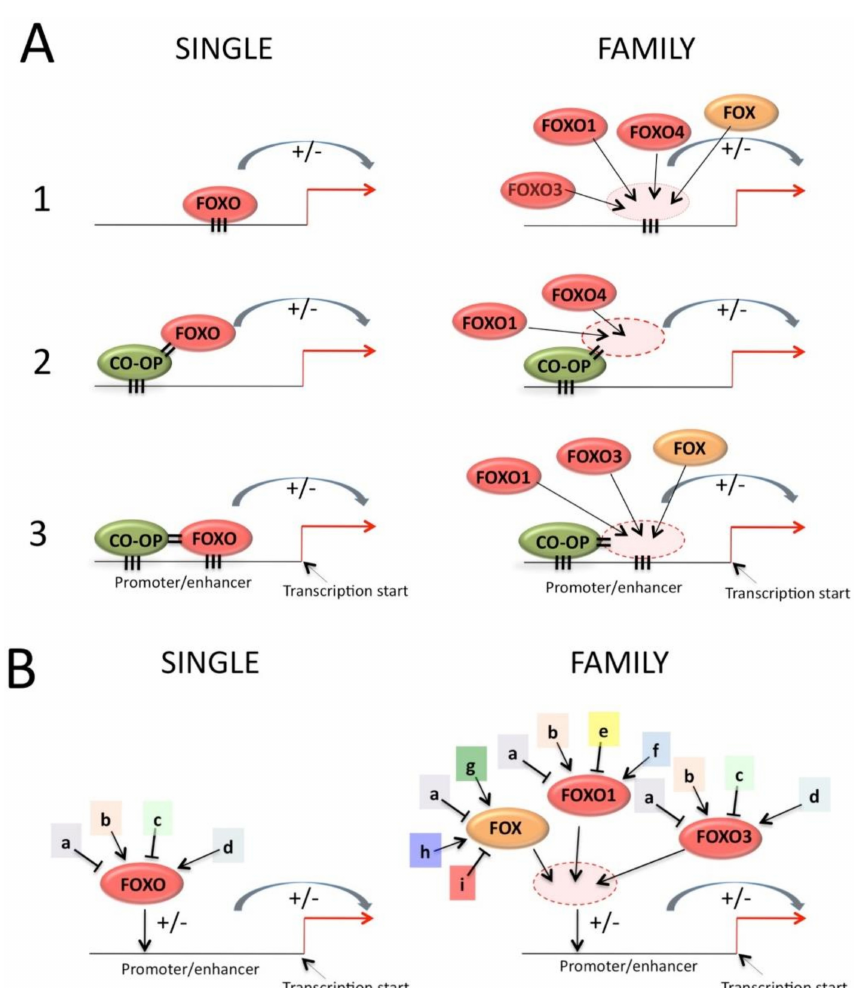
Figure 5. ( A ) Left side: simplified view of the major di ff erent modes of action of FOXOs: 1. Direct DNA-contact, 2. Indirect binding, through another protein making DNA-contact, 3. Pairwise binding, with both proteins making DNA-contact. Right side: Family e ff ect for the di ff erent mode of action. ( B ) Left side: di ff erent pathways can influence activity of FOXOs whatever mode of action it uses. Right side: possible family e ff ects that greatly enhance the possibilities of regulation. All the examples are arbitrary and do not reflect real